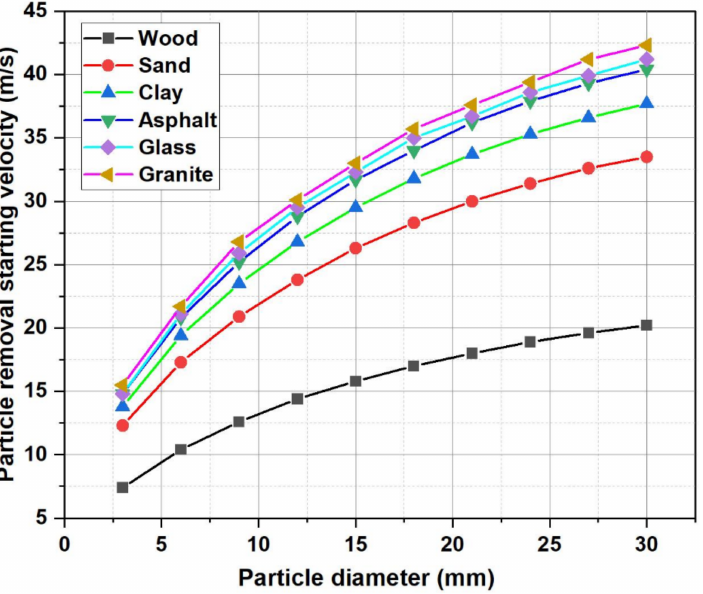
Figure 14. Calculation results of particle removal starting velocity on different particle shape and